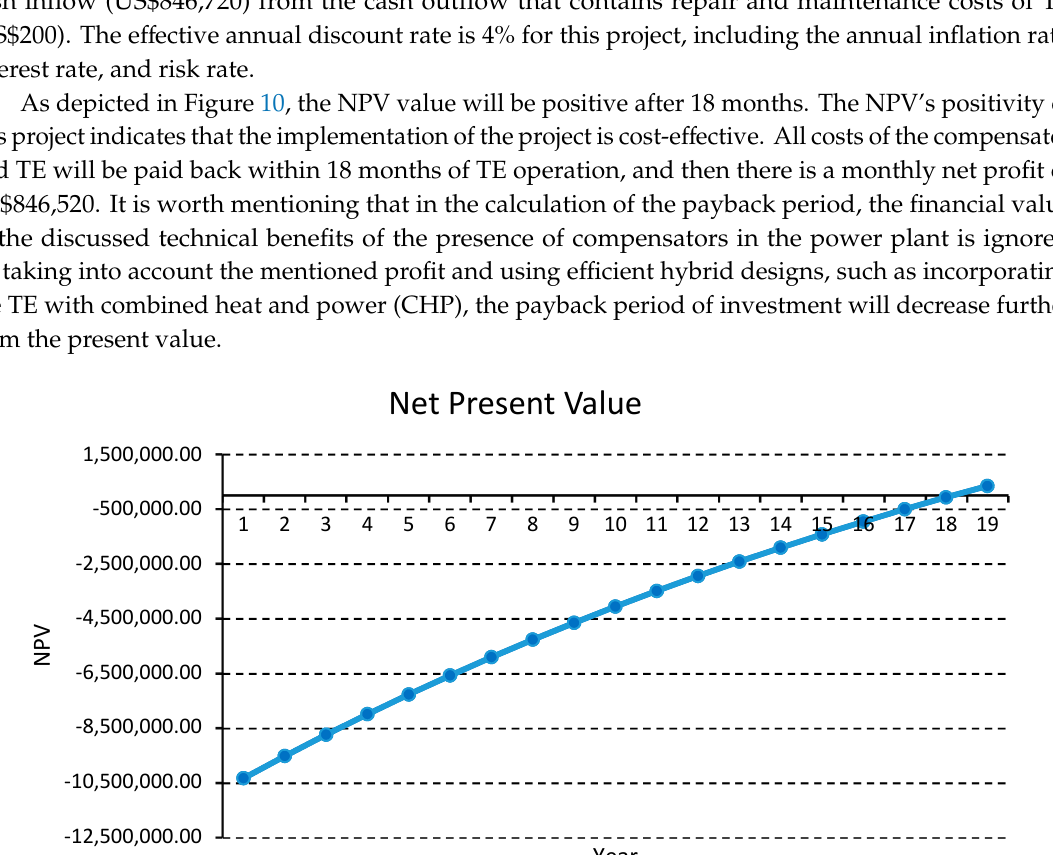
Table 7. Summary of techno-economic assessment for this case study with the grading: superior (+ +